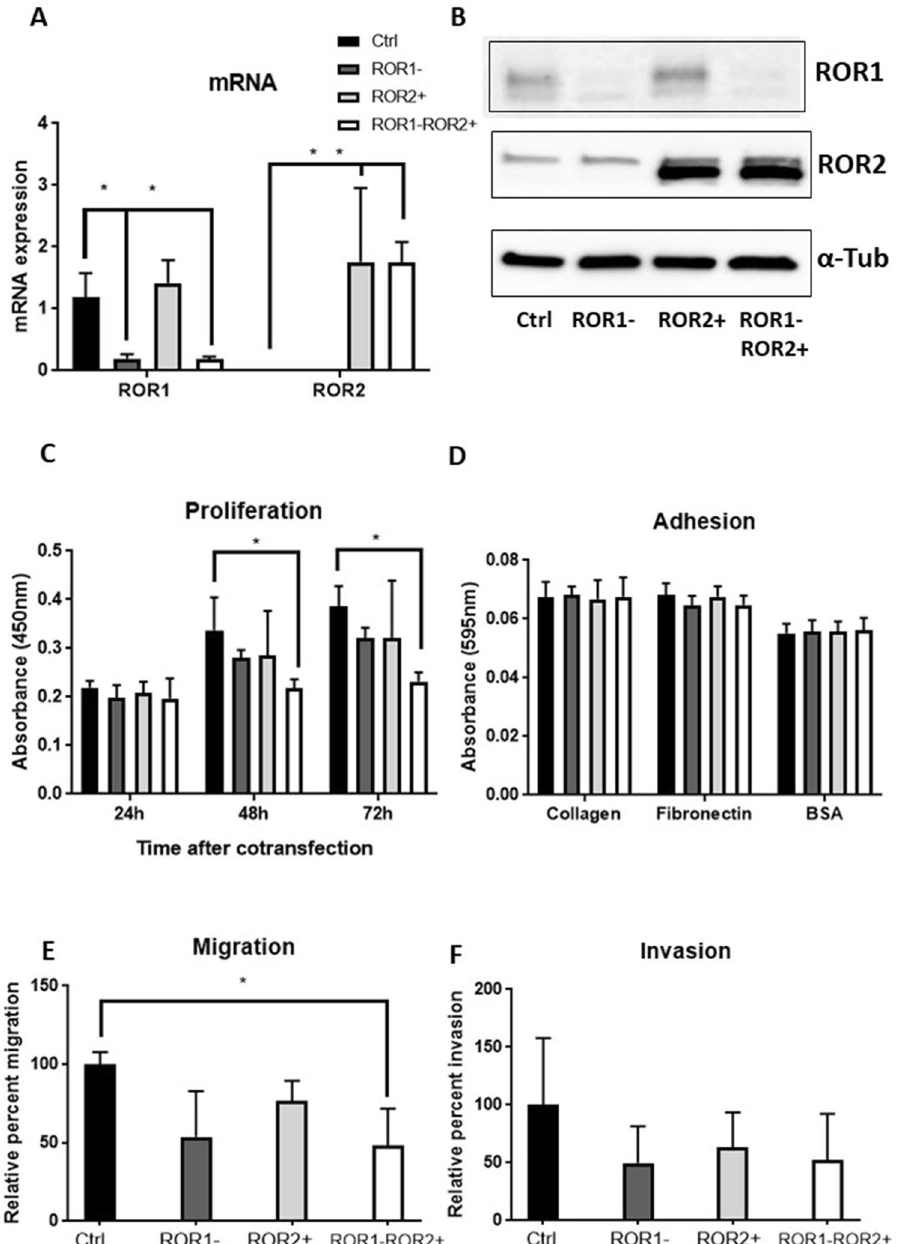
Figure 4. ROR1 knockdown and ROR2 overexpression significantly decreased proliferation and migration of KLE. ( A ) ROR1 mRNA expression level was reduced significantly without changing ROR2 following single ROR1 siRNA transfection. ROR2 mRNA expression level was elevated significantly with no changes in ROR1 mRNA level following single ROR2 plasmid transfection. Cotransfecting ROR1 siRNA and ROR2 plasmid significantly reduced ROR1 while increased ROR2 at mRNA level. ( B ) Representative western blot membranes showed effective delivery of ROR1 siRNA and/or ROR2 plasmid in KLE. ( C ) ROR1 knockdown and ROR2 overexpression significantly reduced the cell proliferation after 48 h and 72 h ( p = 0.043 and 0.004 respectively). ( D ) ROR1 knockdown and/or ROR2 overexpression had no effect on adhesion to collagen or fibronectin. ( E ) ROR1 knockdown and ROR2 overexpression decreased KLE migration ability significantly ( p = 0.037). ( F ) No significant change was observed for invasion following ROR1 knockdown and/or ROR2 overexpression. For all panels n = 3, error bars represent standard deviation of the mean, * p <